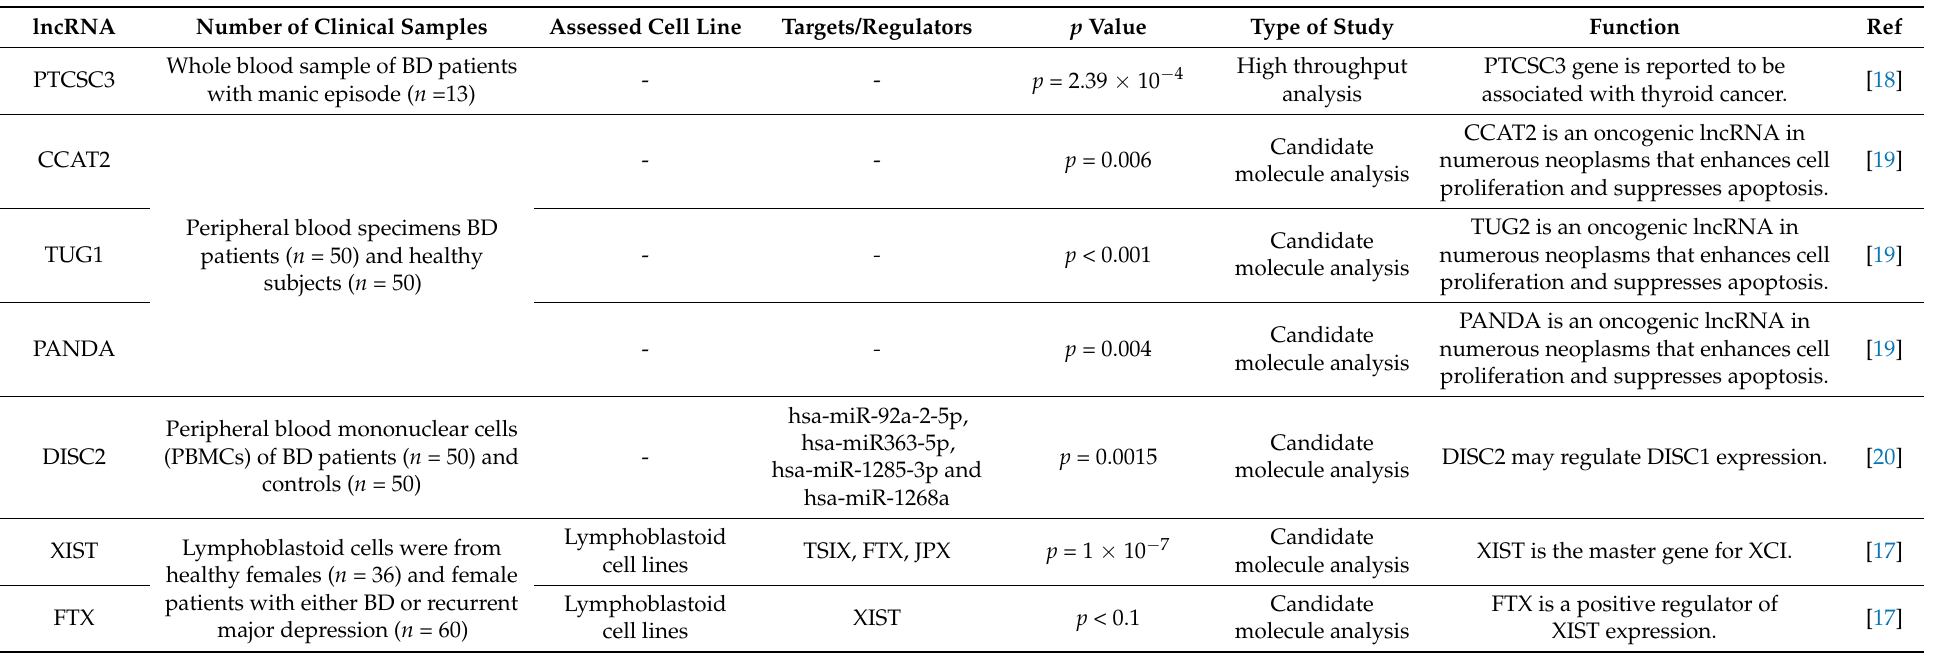
Table 3. Summary of function of up-regulated lncRNAs in BD (BD: bipolar disorder, SZ: